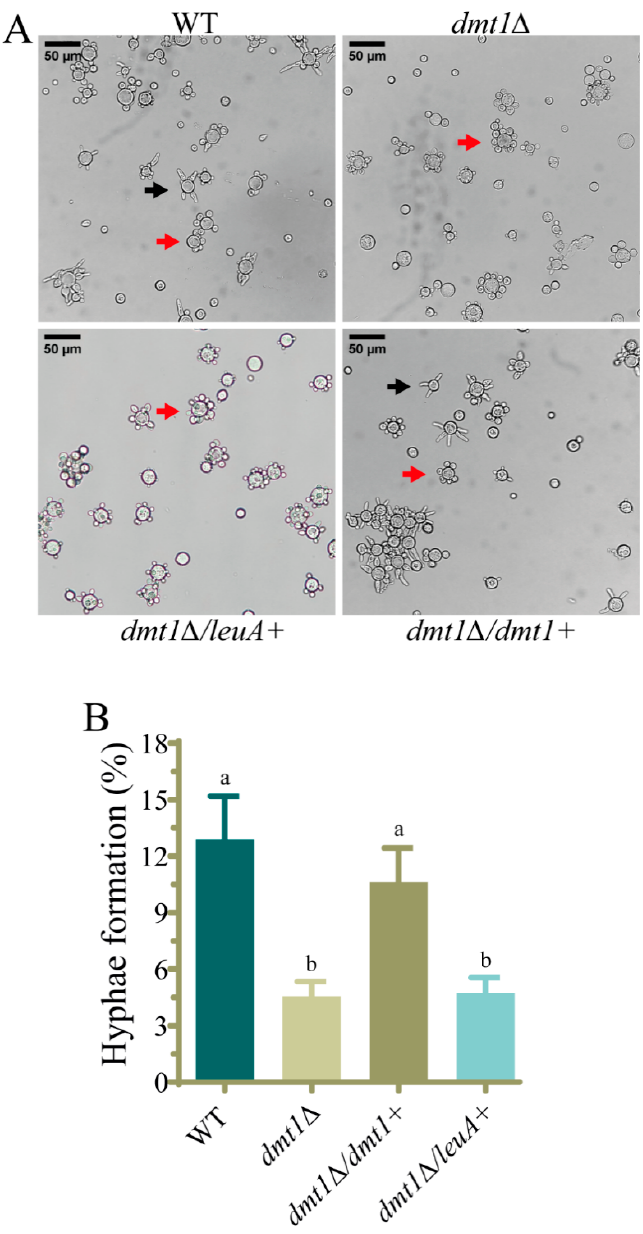
Figure 3. Complementation of dmt1 mutant with the wild-type allele of dmt1 gene recovered the ability to develop hyphae. ( A ) Cells of the wild-type strain MU636 (WT), dmt1 ∆ (MU1317), dmt1 ∆ complemented with dmt1 wild-type allele (MU1331), and dmt1 ∆ complemented with empty cassette (MU1334) 2.5 h after induction of mycelial growth by transferring to aerobic conditions. The arrows indicate the multipolar budding yeasts (red) and cells with germinated hyphae (black). ( B ) Percentage of yeasts with developed hyphae in wild type (WT) strain and the indicated strains calculated from 200 total cells. The charts display means ± SD. Different letters indicate statistically significant differences, while the identical letters denote no significant differences, calculated using one-way ANOVA ( p < 0.001, Tukey test). Three independent experiments were conducted for each